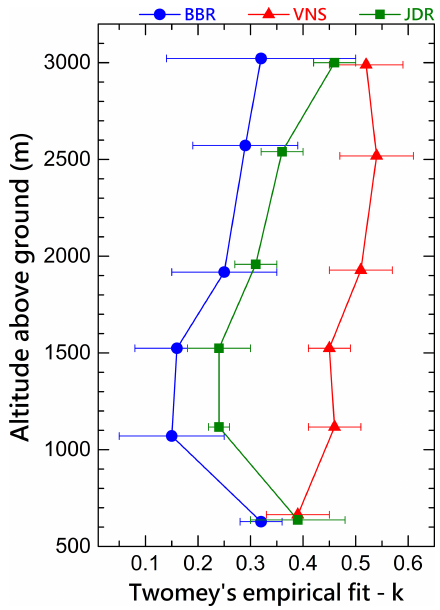
Figure 7. Altitude variation of k (Twomey’s empirical fit) over the eastern (BBR; circle), central (VNS; triangle) and western (JDR; square) IGP regions. Error bars represent the standard deviation of the fit.